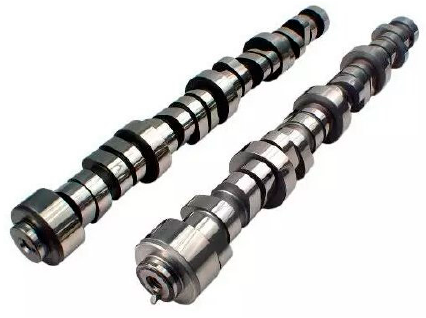
Figure 1. Image of the industrial camshaft.